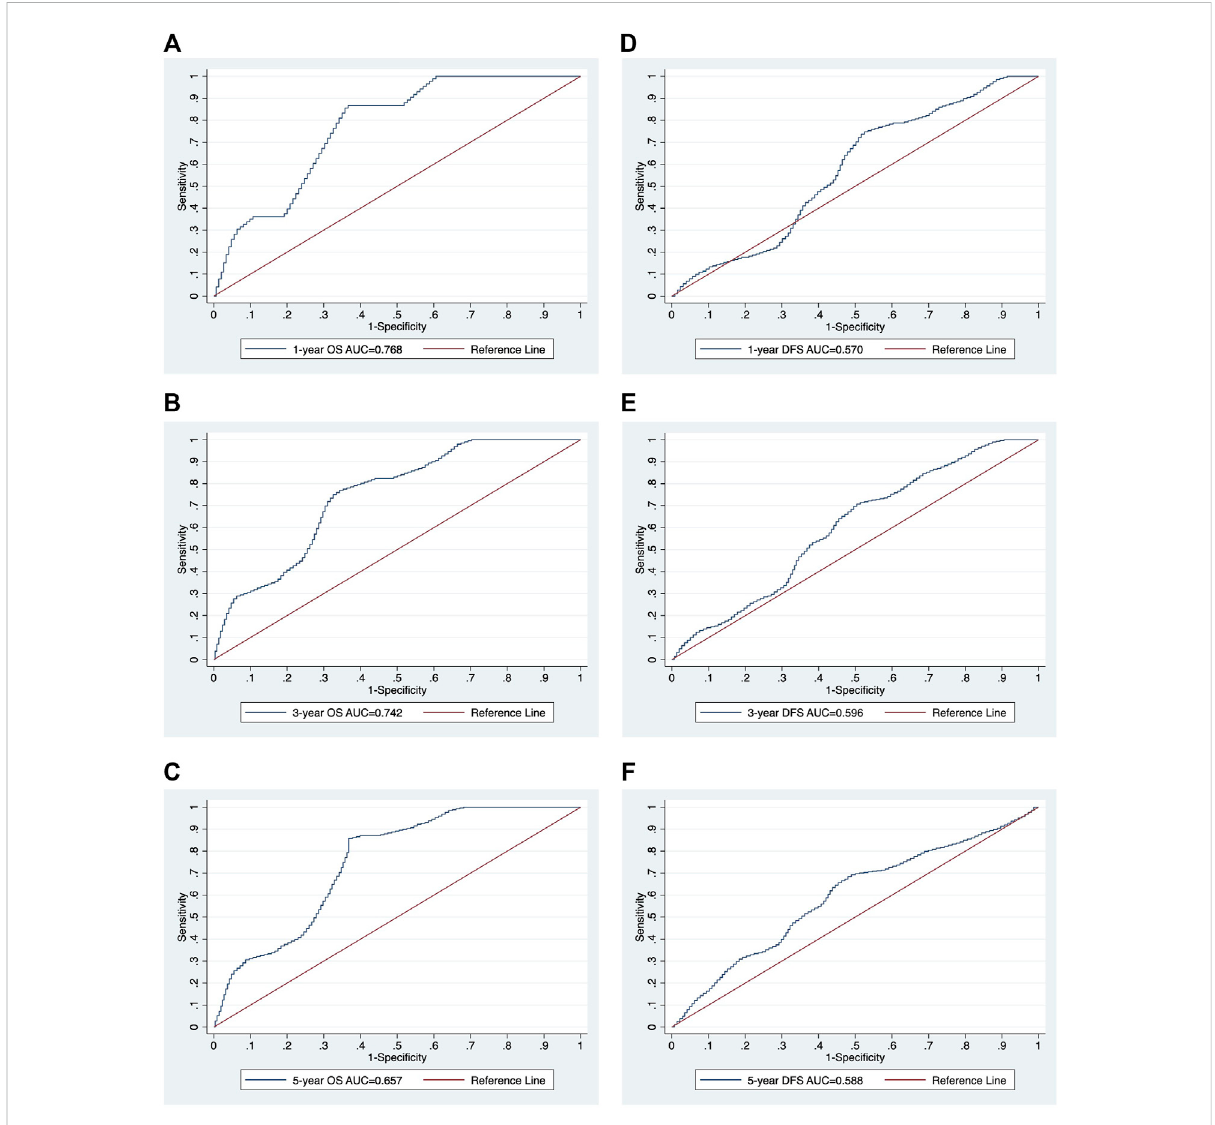
FIGURE 4 Thetime-dependentROCcurveanalysisofPNIfor1-,3-,and5-yearsurvival.TheROCcurvesofPNIfor1-,3-,and5-yearsurvivalOS (A-C) and DFS (D-F) .ROC,receiveroperatingcharacteristic;AUC,areaunderthecurve;PNI,prognosticnutritionalindex;OS,overallsurvival;DFS,disease-free